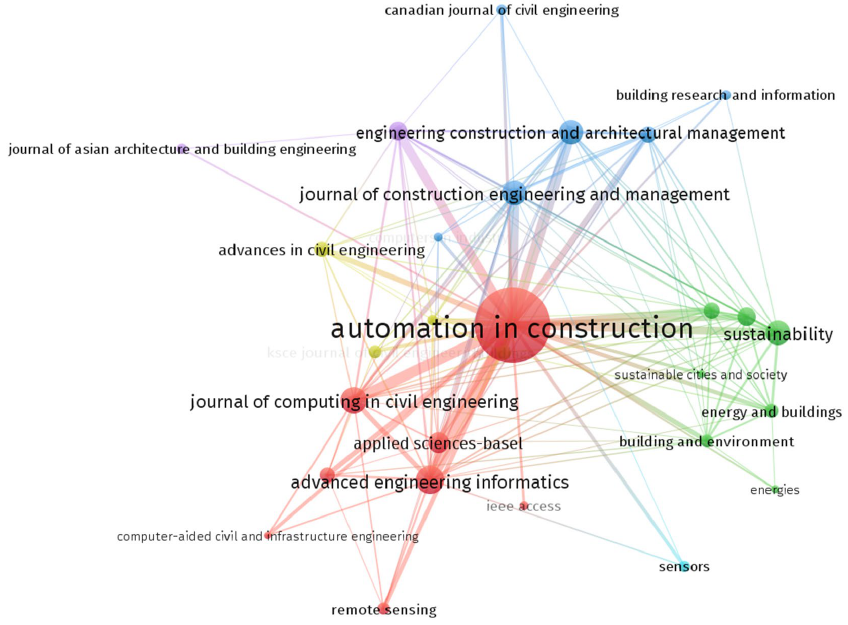
Figure 6. Mapping of the citation of sources